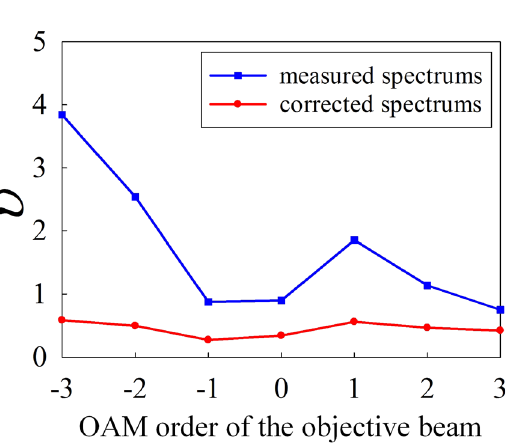
Figure 7. ( a ) and ( b ) shows the results of the measured OAM spectrum, and the corrected OAM spectrum with objective beam carrying OAM of l = − 2 and tilt angle of − 3.37 × 10 − 4 rad , and the OAM spectrum dispersion factor of ν = ∑